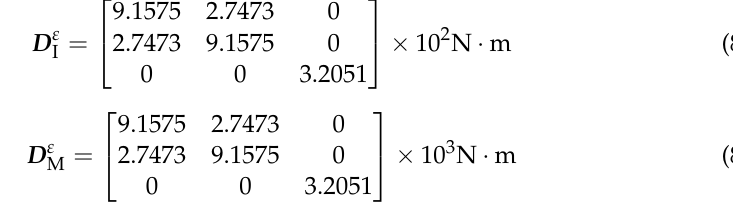
Figure 8. Single-layer periodic plate and its unit cell. ( a ) 2D periodic plate with single inclusion; ( b ) Figure 9. Second-order influence function 𝝌 2 of the CCCC single-layer periodic plate. ( a ) 𝑚𝑛 = 2D unit cell; ( c ) 3D representative unit cell. 11 ; ( b ) 𝑚𝑛 = 22 ; ( c ) 𝑚𝑛 = 12.